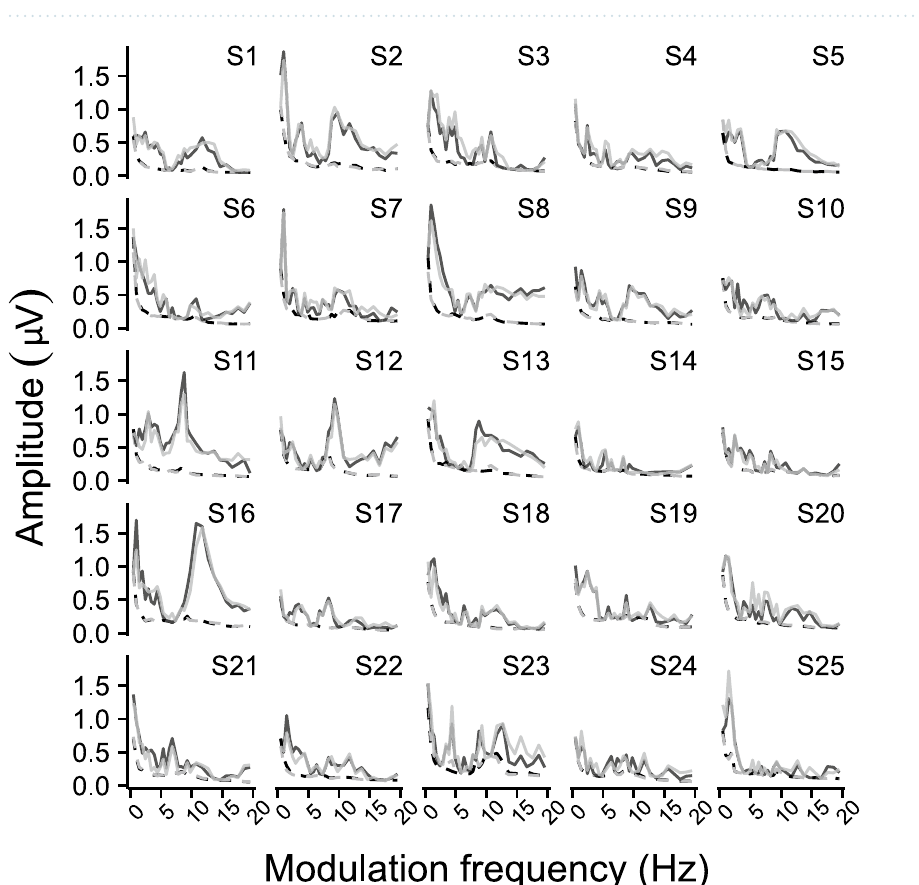
Figure 5. Individual TMTF ASSR within the 0.5–20 Hz region. The different panels show the biased response amplitude as a function of modulation frequency per subject. Solid lines represent the ASSR amplitude, whereas the dashed lines represent the neural background noise. The left and right hemispheric channel are shown in black and gray, respectively. Comparing the subject-specific TMTF ASSR show that there is a high inter-subject variability in response magnitude for ASSRs evoked with modulation frequencies ≤ 20